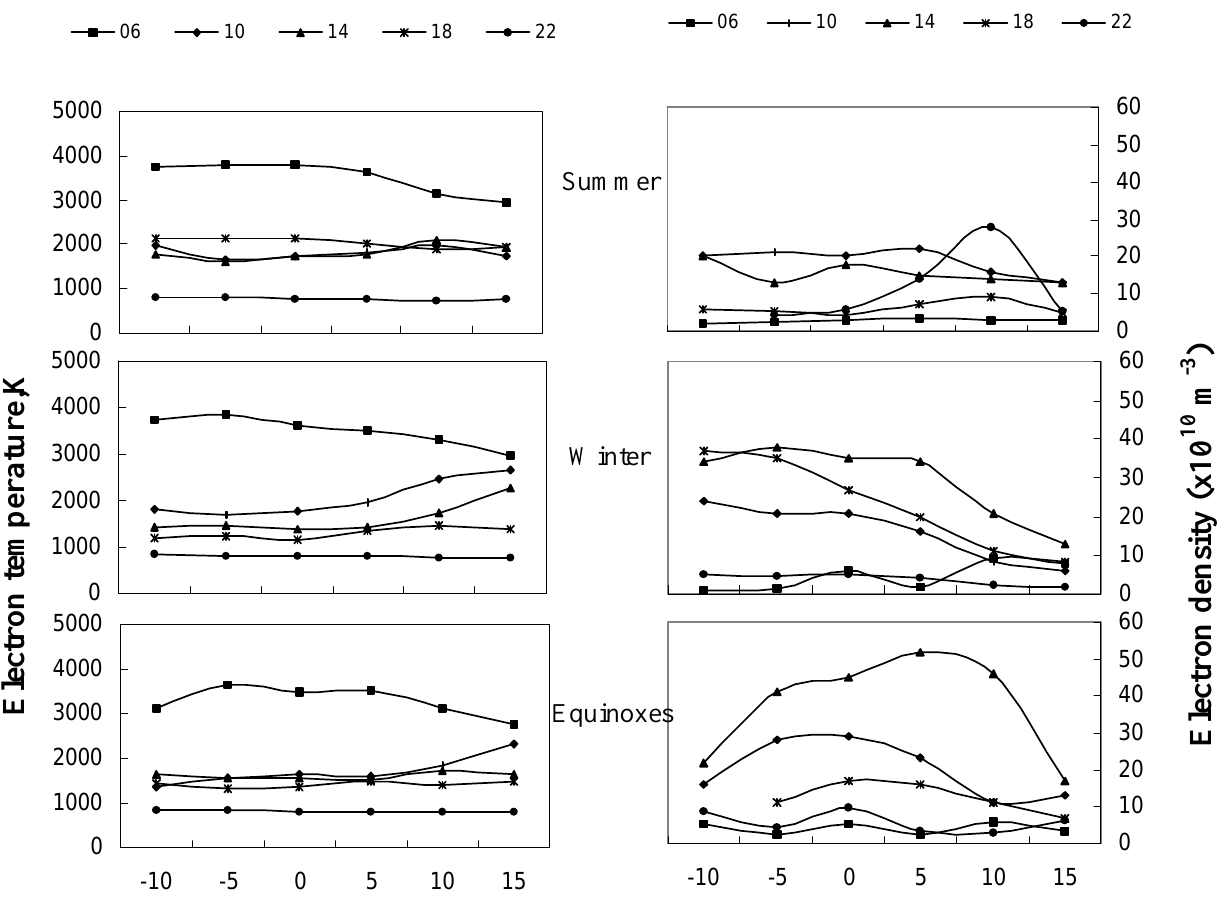
Fig. 8. Latitudinal variation of observed electron temperature (left panels) and electron density (right panels) at selected local